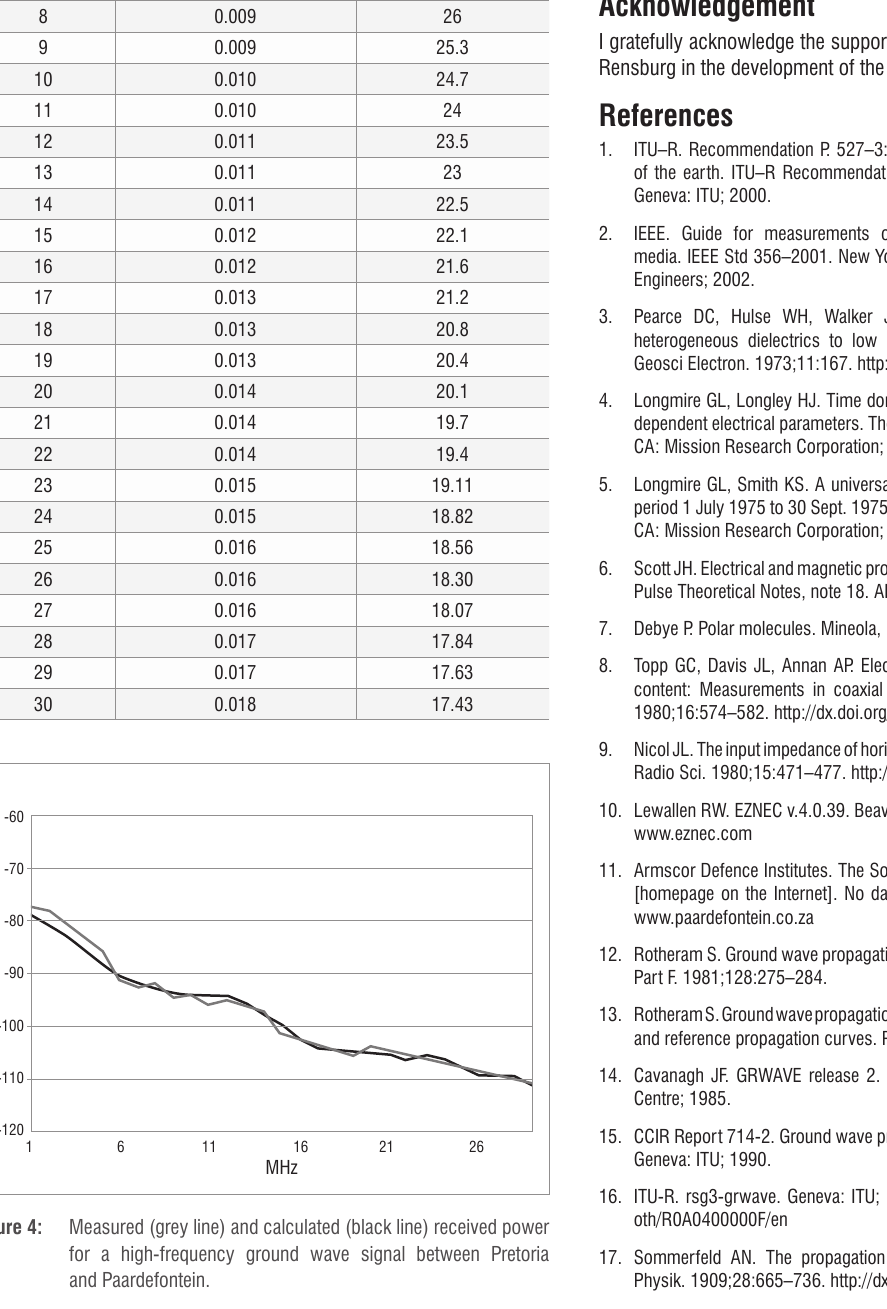
dielectric constant ( ε ) r